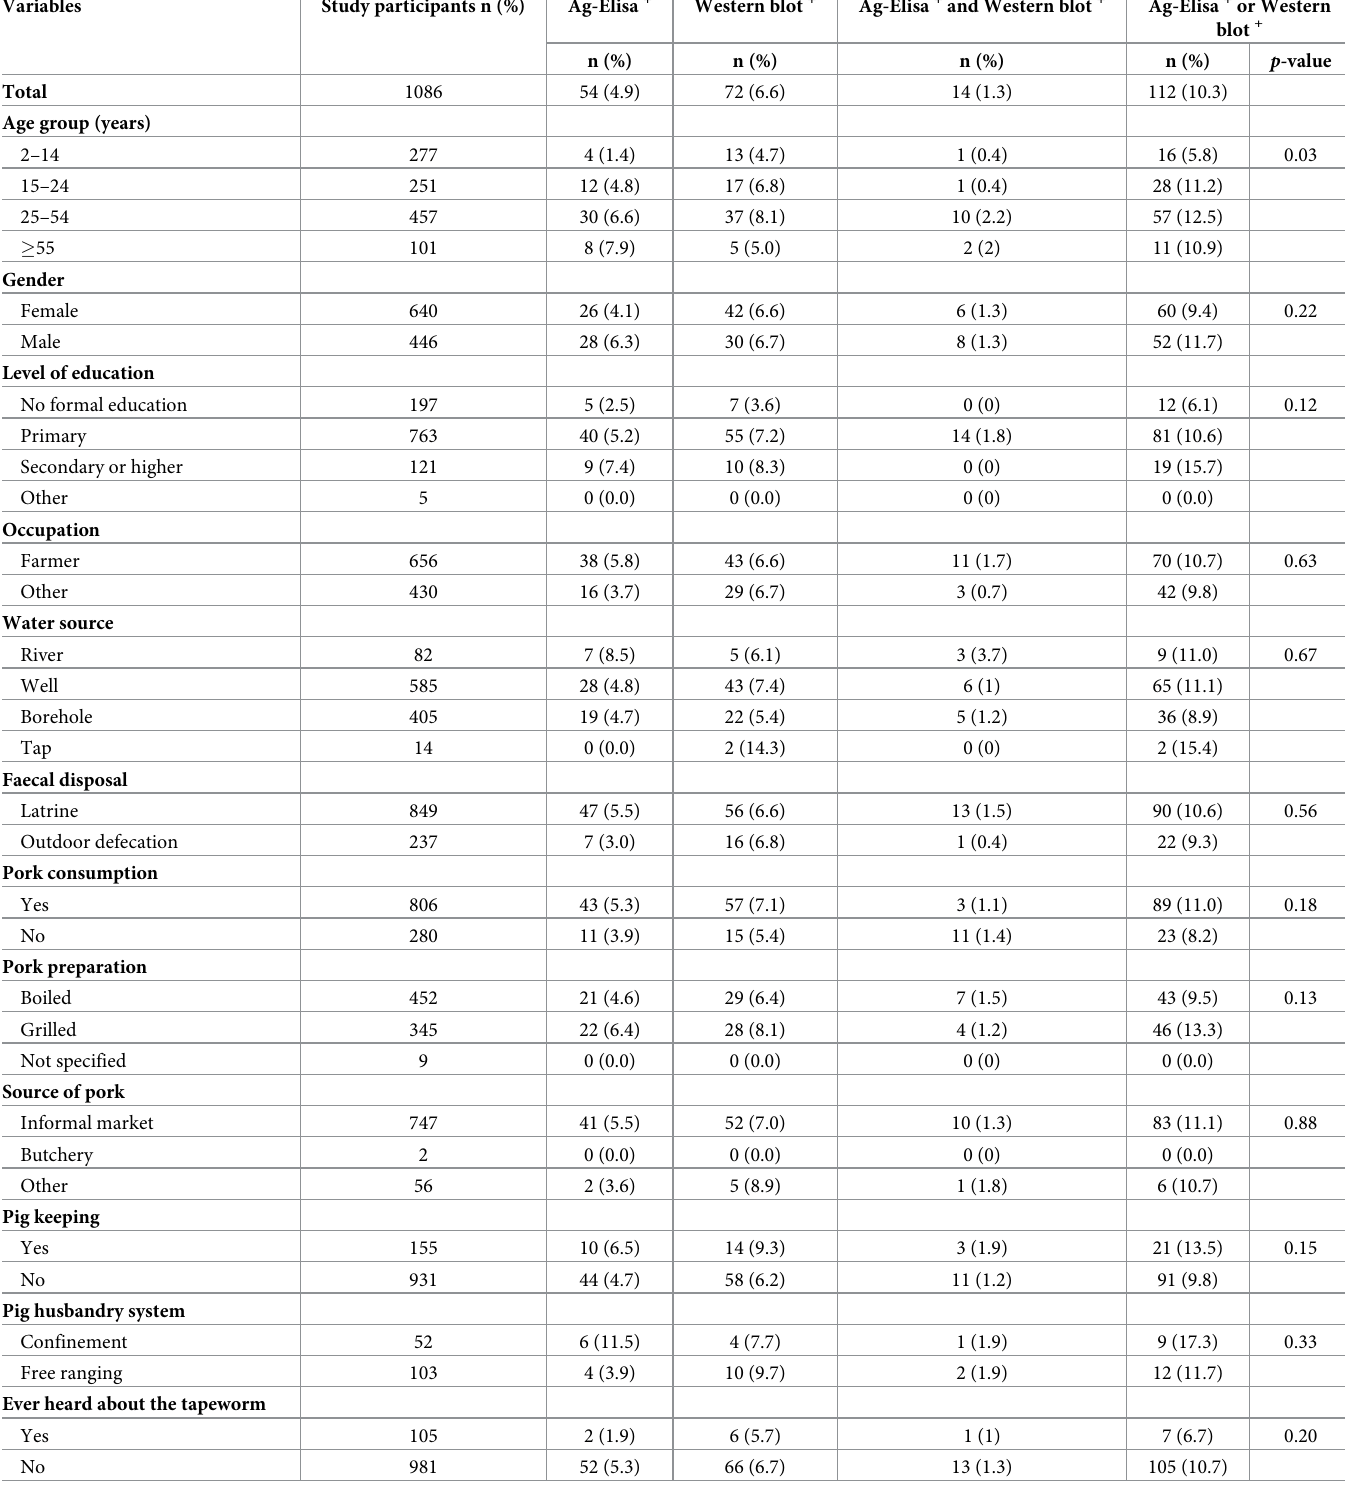
Table 2. Socio-demographic data and relation with serological assays to T . solium larva antigens and